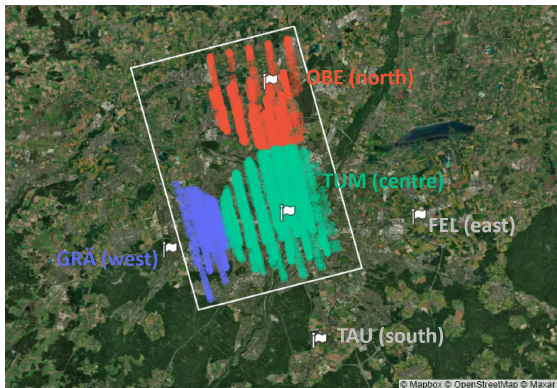
Figure 5. This figure illustrates the collocation criteria for target overpass data captured on 31 March 2021. OCO-2 soundings within a radius of 6km are compared to measurements of the collocated MUCCnet instrument. The OCO-2 target soundings are colored ac- cording to their collocated ground-based spectrometers.